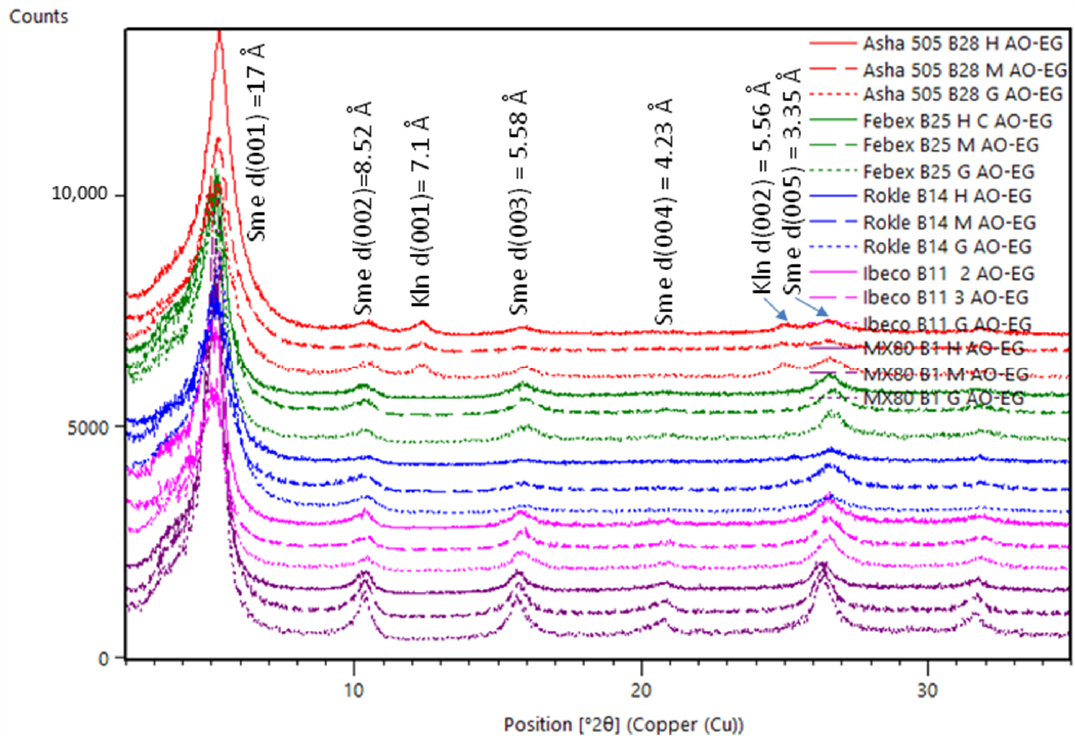
Figure 6. XRD patterns of oriented aggregate samples (after ethylene glycol treatment).